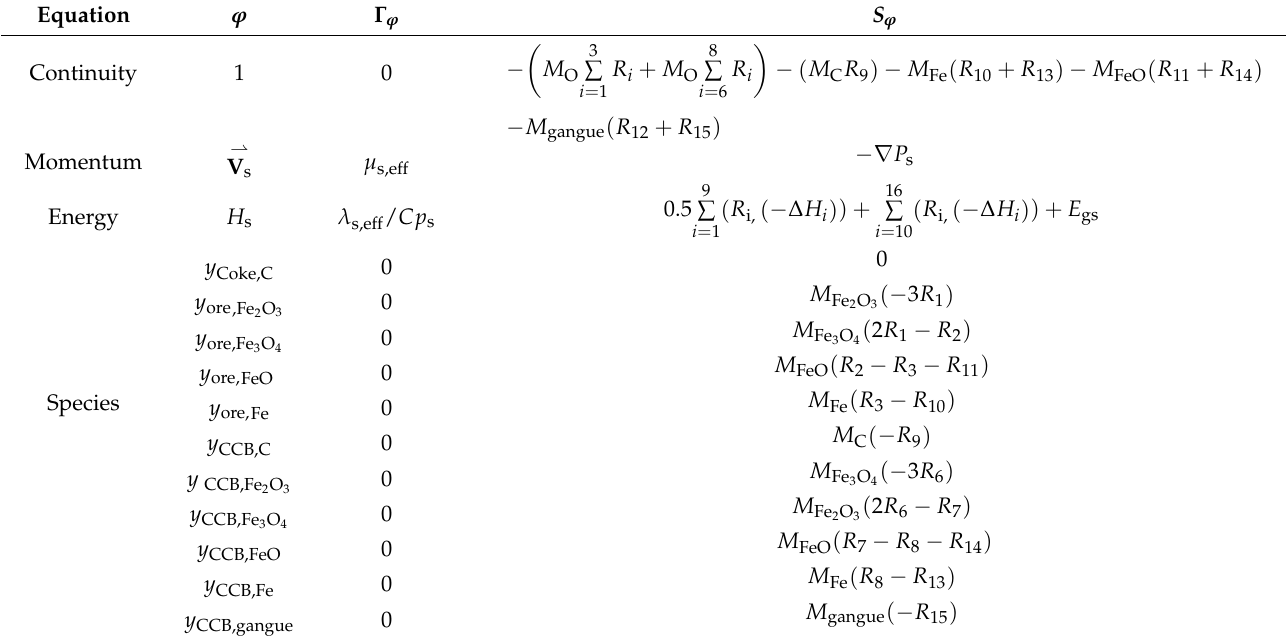
Table 5. Dependent variables and sources in Equation